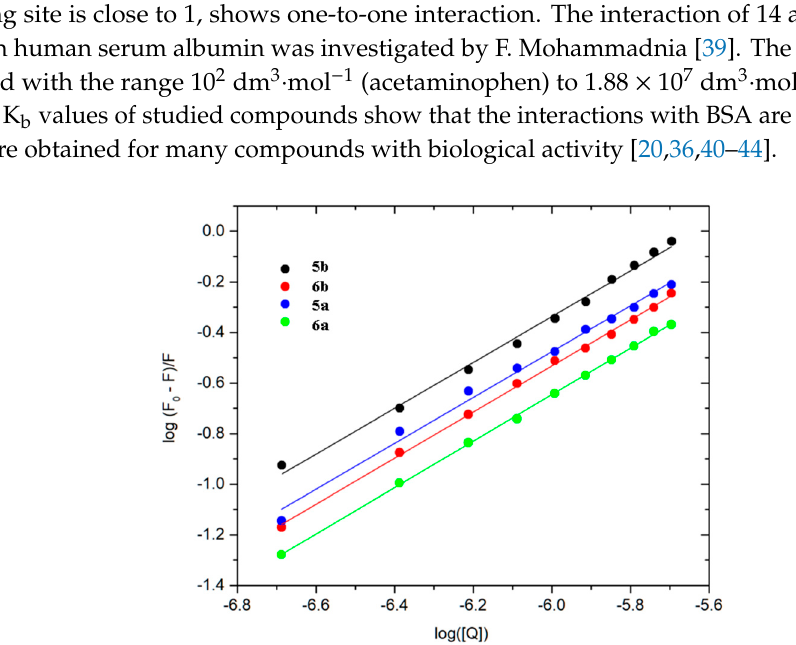
Figure 7. Double logarithm regression plots for quenching of BSA by 5a , 5b , 6a , and 6b.